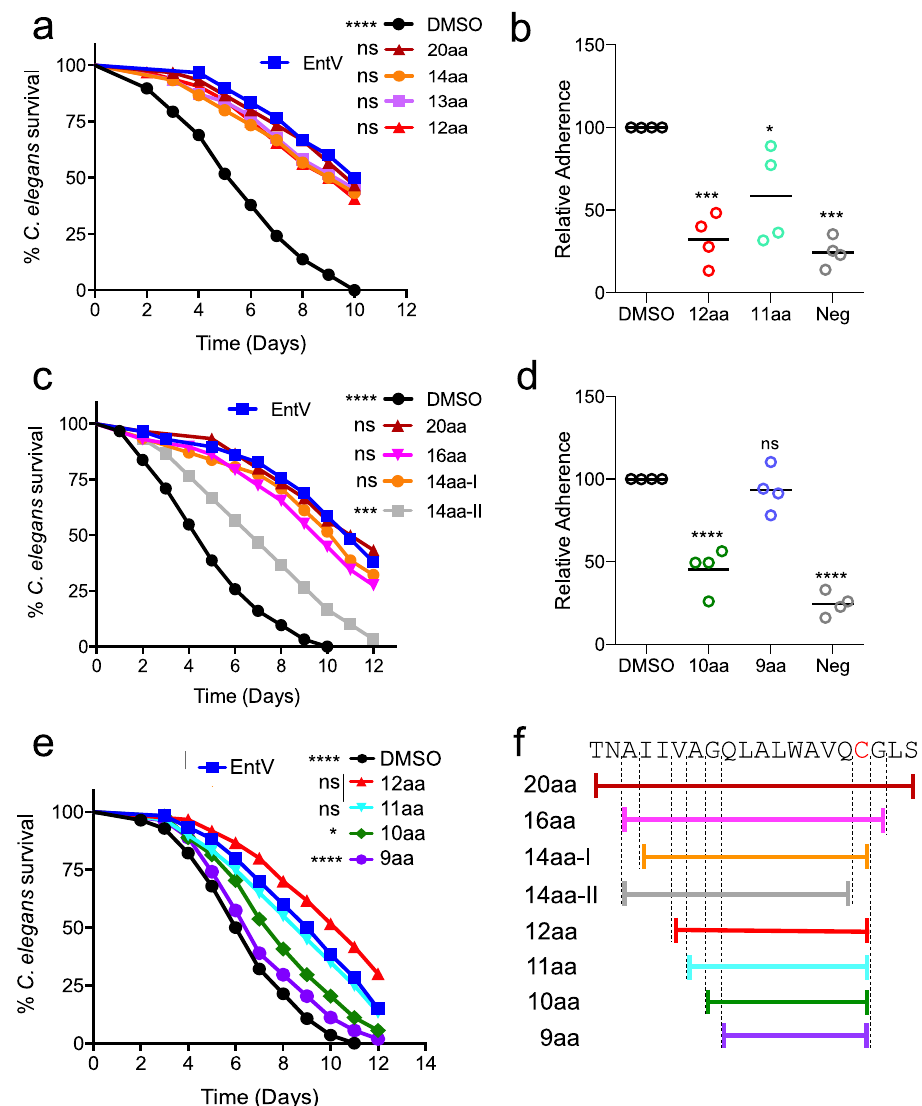
Fig.3|Shortervariantsof α 7retainantifungalactivity.a , c , e showsurvivalover timeof C.elegans infectedwith C.albicans andexposedto1nMoftheindicated α 7 fragmentasshownin f .Statisticaldifferencesinsurvivalwerecomparedtoanimals in the exposure condition on the left of each legend by Mantel – Cox log rank analysis. An n of 60 was used and one representative trial is shown. Exact p values from top to bottom: a <0.0001, 0.7721, 0.4591, 0.5702, 0.3797, c <0.0001, 0.7958, 0.2951, 0.5476, 0.0002. e <0.0001, 0.0489, 0.5844, 0.0127, <0.0001. Median sur- vival and p values of all trials are shown in Supplementary Data 1. b , d show